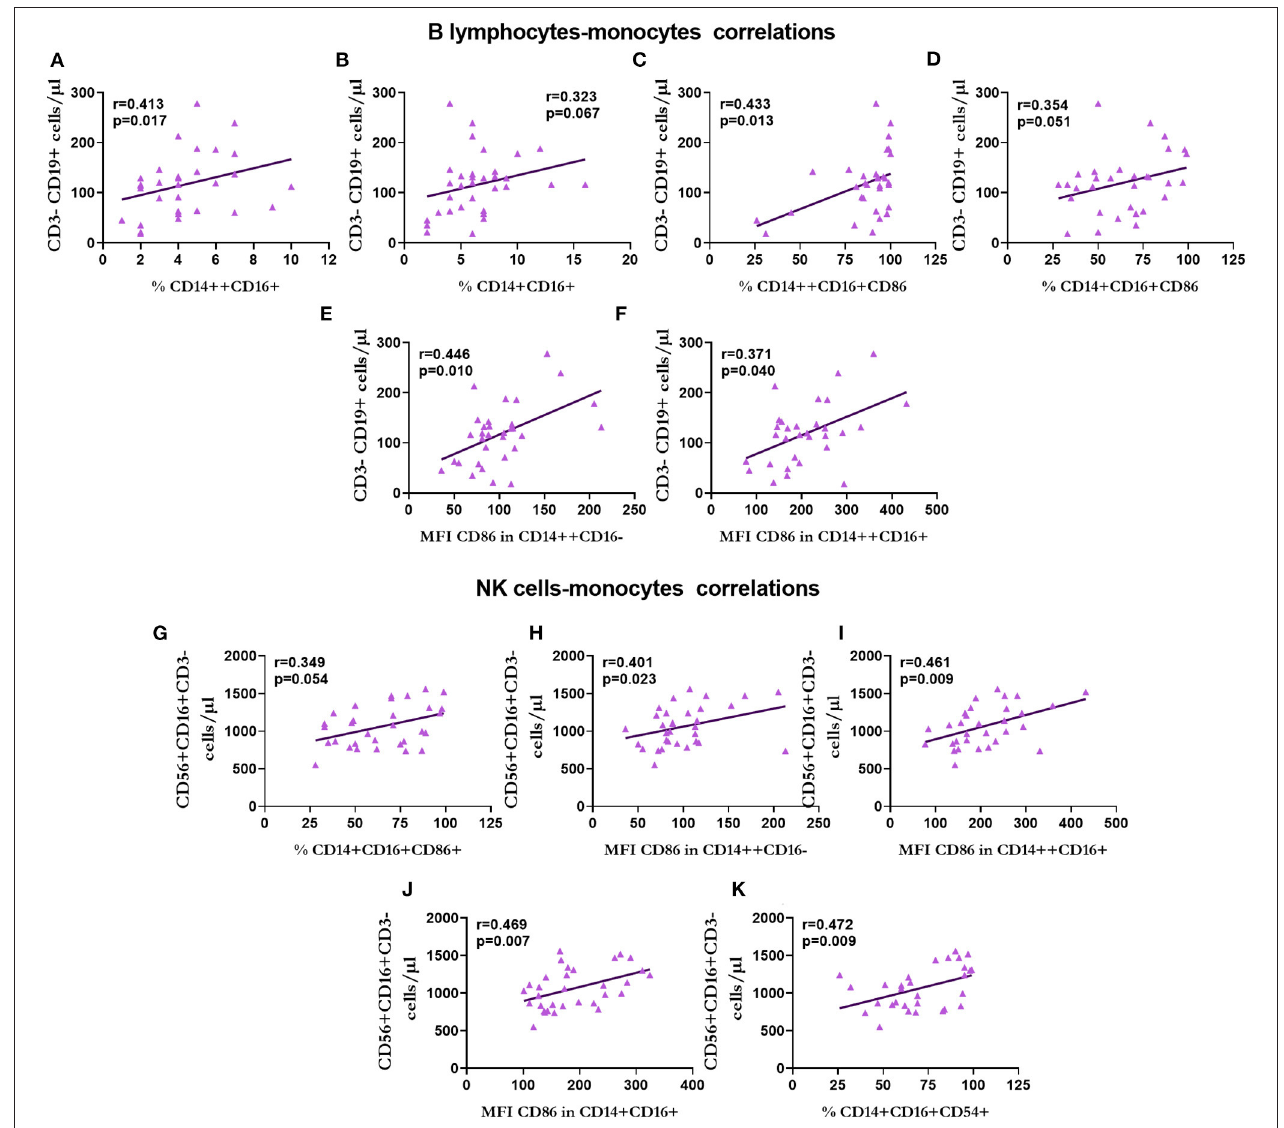
FIGURE 10 | Correlation between the number of B lymphocytes and natural killer (NK) cells with monocytes in renal transplantation. Correlation between B lymphocytes and the percentage of intermediate (A) and non-classical (B) monocytes, the percentage of intermediate (C) and non-classical (D) CD86 + monocytes and the expression of CD86 in classical (E) and intermediate (F) monocytes. Correlations of NK cells with the percentage of CD86 + monocytes (G) , expression of CD86 in classical (H) , intermediate (I) , and non-classical (J) monocytes, and the percentage of non-classical monocytes expressing CD54 (K) are